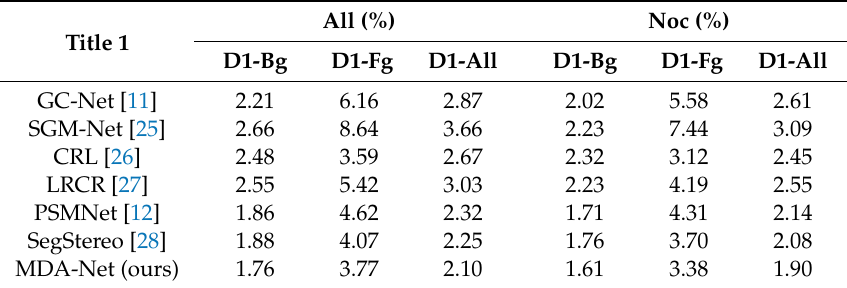
Table 3. The comparison results on KITTI 2015 test set.